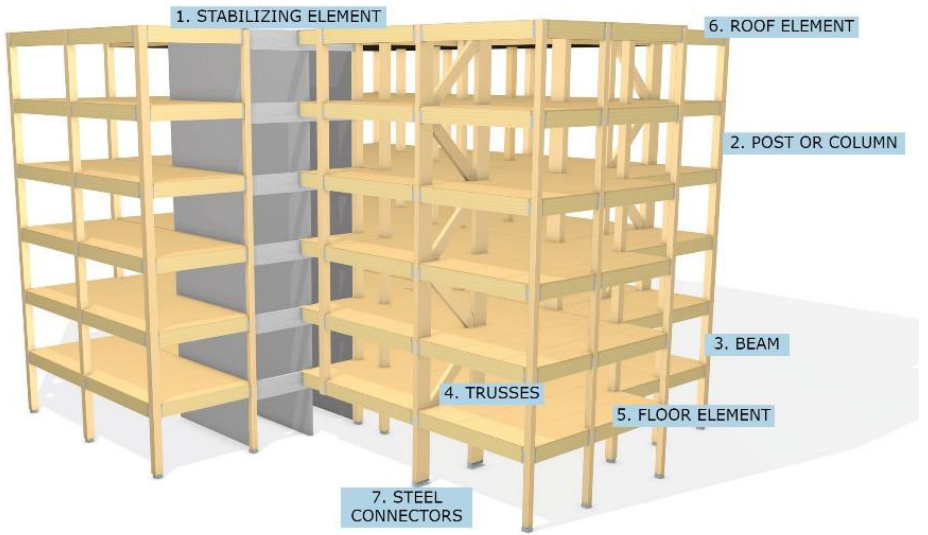
Figure 2. Components of the Trä 8 building system.